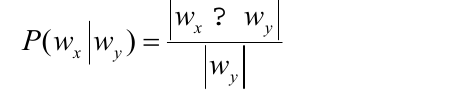
Figure 2. A tweet posting disaster relief information after Japan